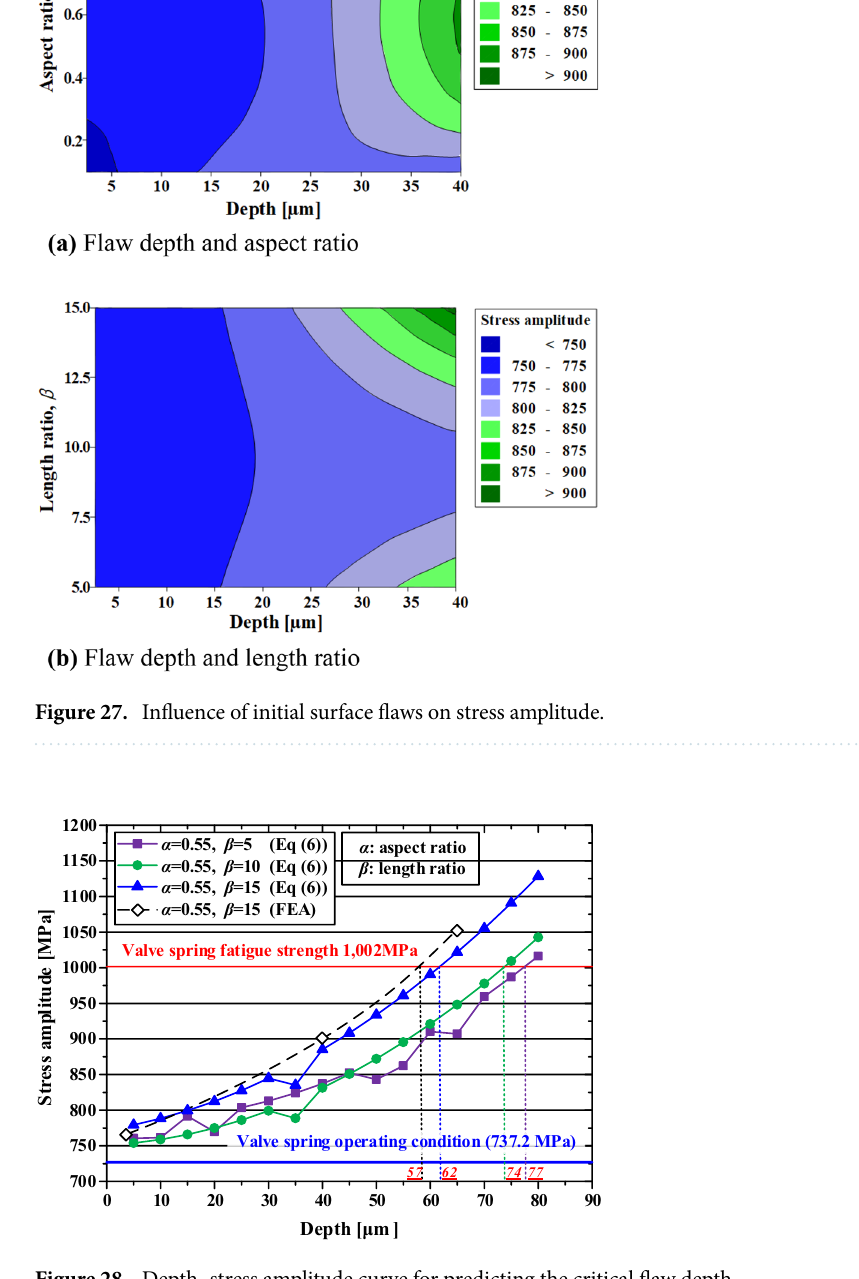
Figure 28. Depth–stress amplitude curve for predicting the critical flaw